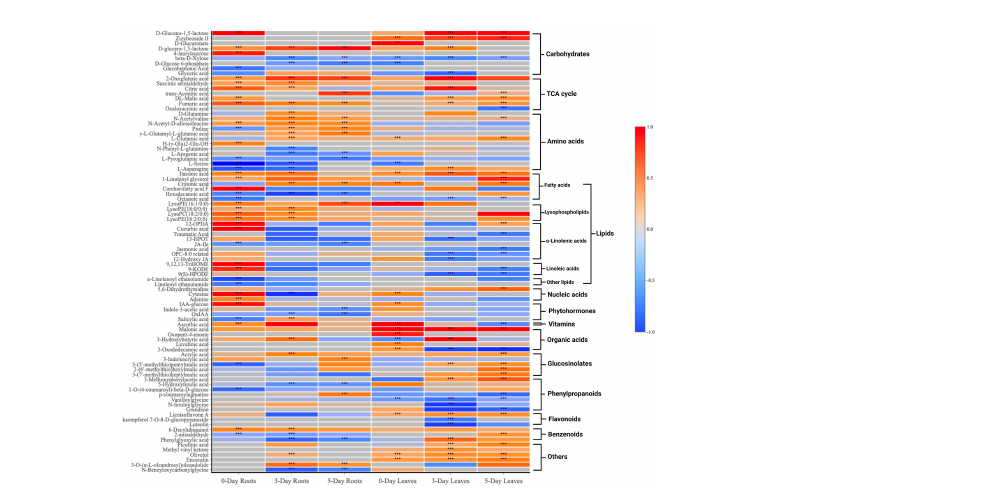
FIGURE 4 A heatmap of 89 compounds of interest and their classi fi cation in both roots and leaves at 0, 3, 5 days after SWE treatment. Red and blue color represent the increased or reduced accumulation of metabolites respectively. The asterisks indicate signi fi cant differences (t-test and p-value <0.05) between the treated and the control samples.